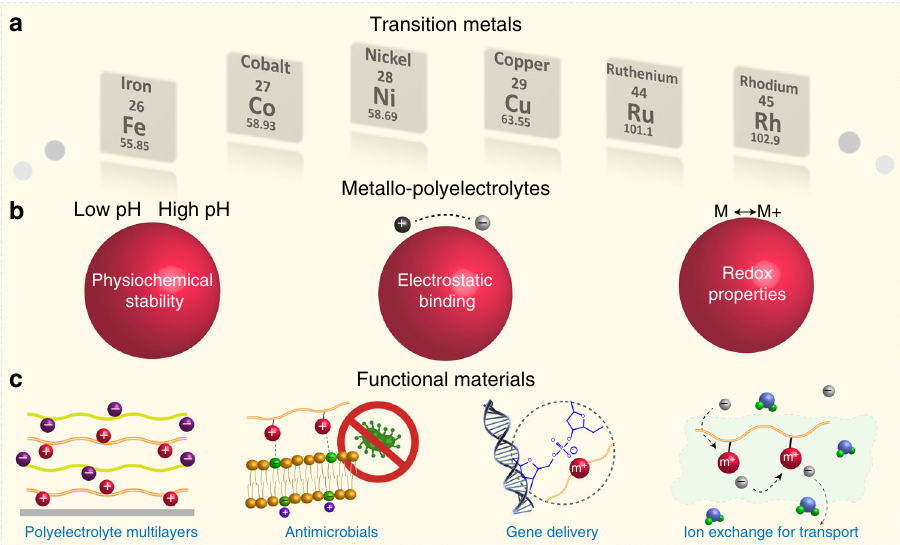
Fig. 2 An overarching summary to illustrate a few key functions of metallo-polyelectrolytes. a most common transition metals for building metallo- polyelectrolytes; b a few properties of metallo-polyelectrolytes including electrostatic binding, redox and physiochemical stability; c applications in the areas of polyelectrolyte multilayers, antimicrobials, gene delivery and ion exchange for